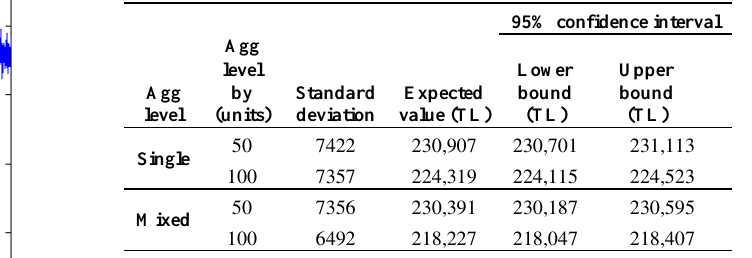
Table 5. The analysis results for each aggregation